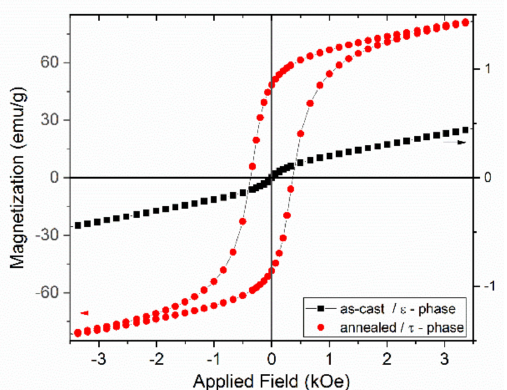
Figure 6. Hysteresis loops for samples Mn 53 Al 45 C 2 as-cast and annealed at 700 ◦